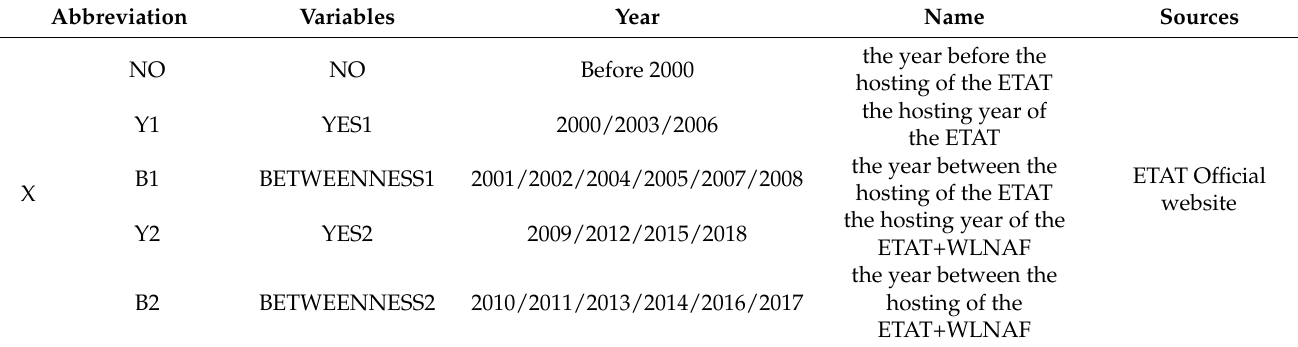
Table 1. Categorical variables.